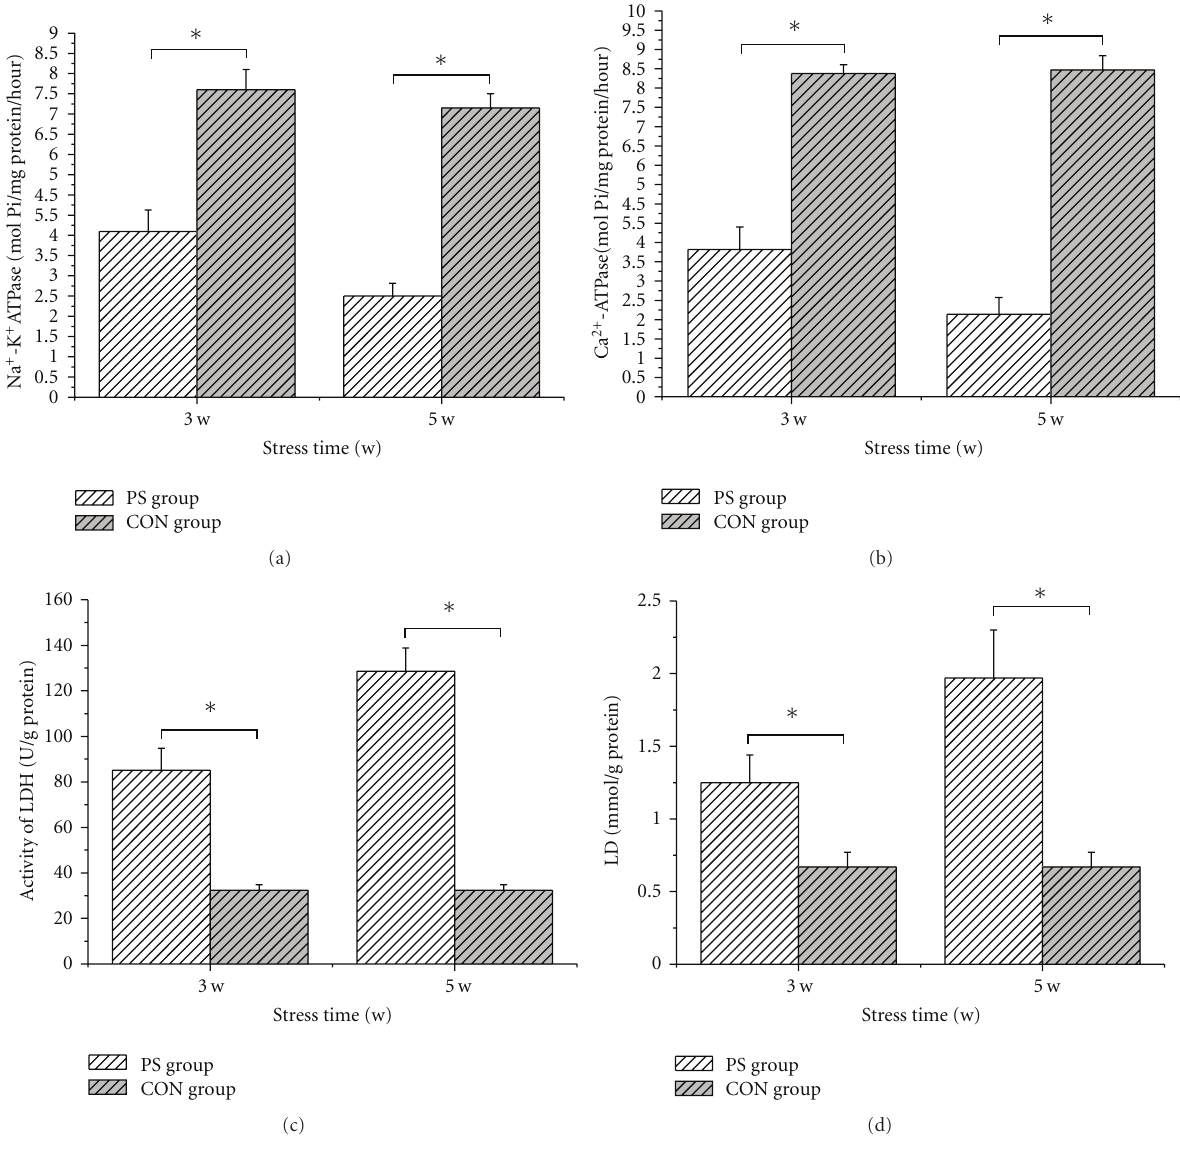
Figure 5: The activities of Na + -K + ATPase, Ca 2+ -ATPase, and lactate dehydrogenase (LDH) and the contents of lactic acid (LD) of the masticatory muscle. Shown are the activities of the enzymes Na + -K + ATPase (a), Ca 2+ -ATPase (b), and Lactate dehydrogenase (c) as well as the contents of lactic acid (d) in the masticatory muscles from the control (CON) and psychological (PS) groups detected by colorimetric methods. Data were expressed as X ± SE and analyzed in eight rats from each group ( ∗ P < .05, PS group versus CON group).